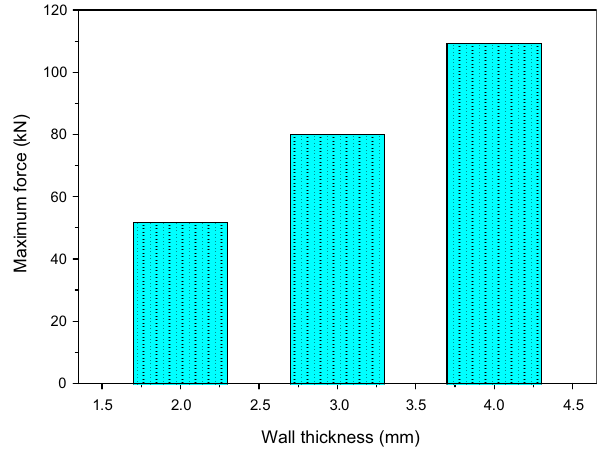
Figure 12: The maximum force generated during axial loading with three di ff erent wall thicknesses.